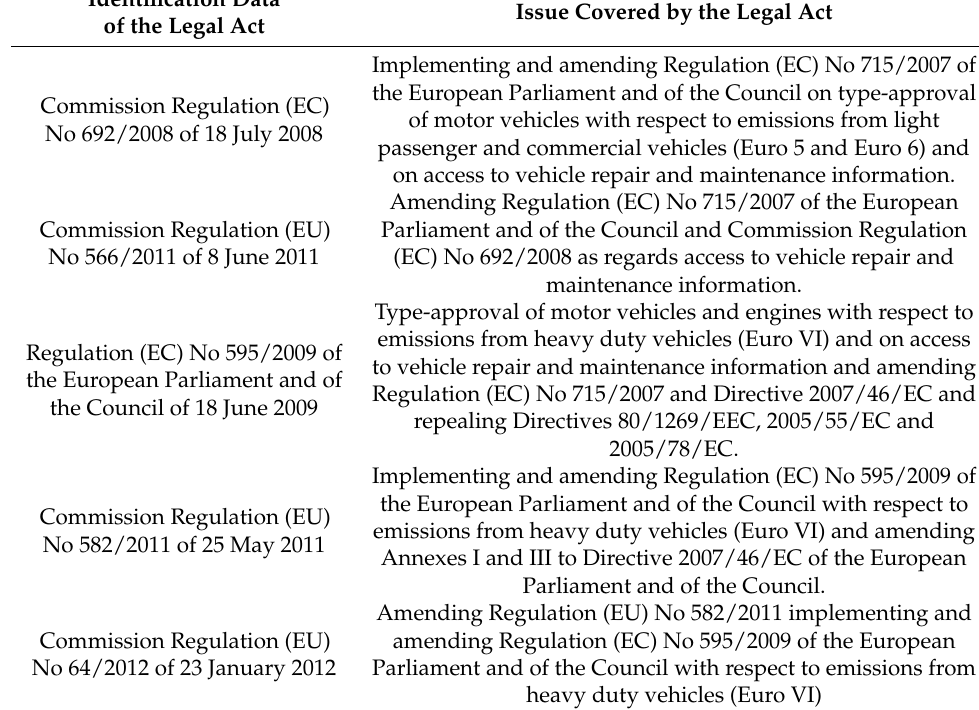
Table 2. Documents currently enforced by the European Union at the level of conventionally